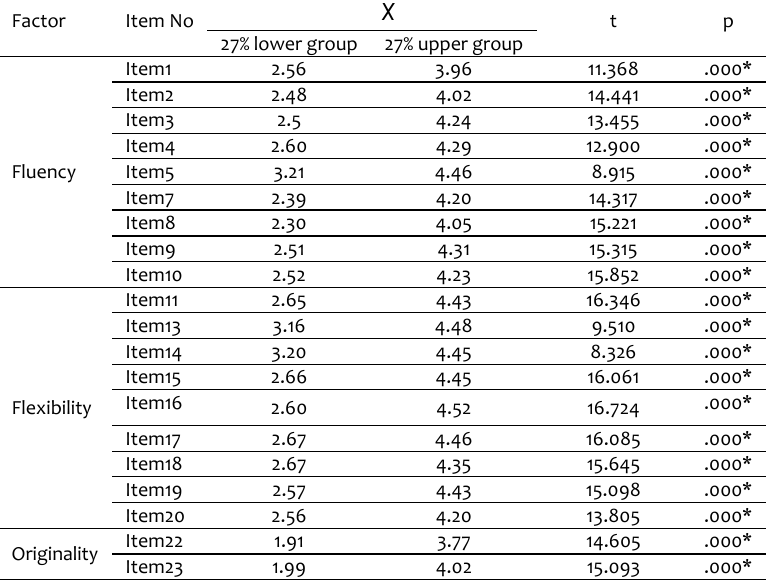
Table 4: Independent Samples T-test Results Regarding the Differences Between the Mean Scores of 27% Lower and 27% Upper groups